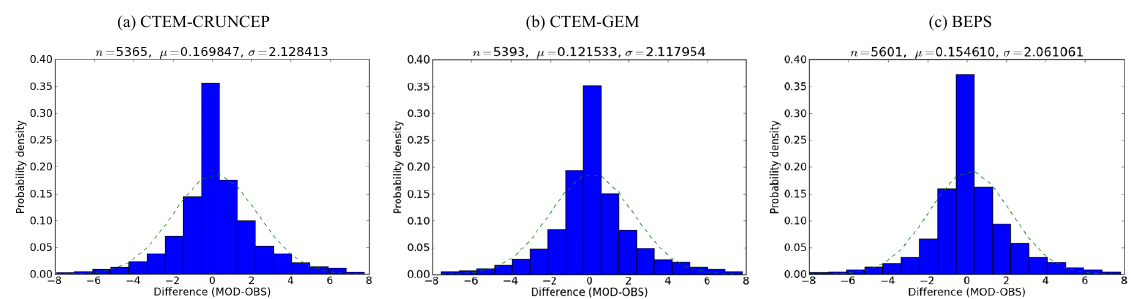
Figure 15. Frequency distributions of the residuals between modeled, using (a) CTEM-CRUNCEP, (b) CTEM-GEM, and (c) BEPS prior fluxes, respectively, and observed CO 2 concentrations, where n is the number of the assimilated observations, µ is the mean bias, and σ is the mean standard